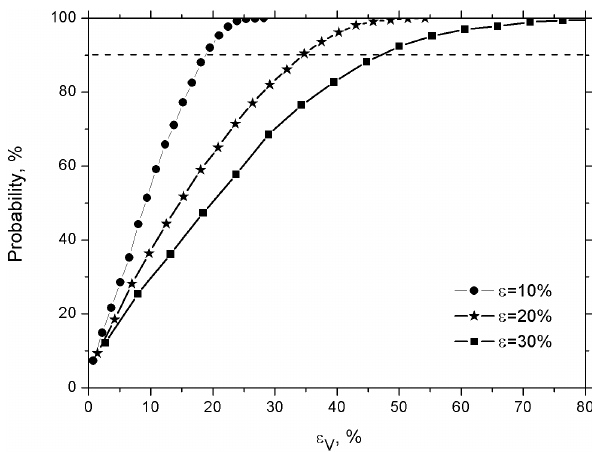
Fig. 2. Cumulative probability of uncertainty ε V of volume density retrieval from 3 β +2 α data with input errors ε =10%, 20%, 30%. Simulation was performed for r 0 =0.2 µm using volume kernels.